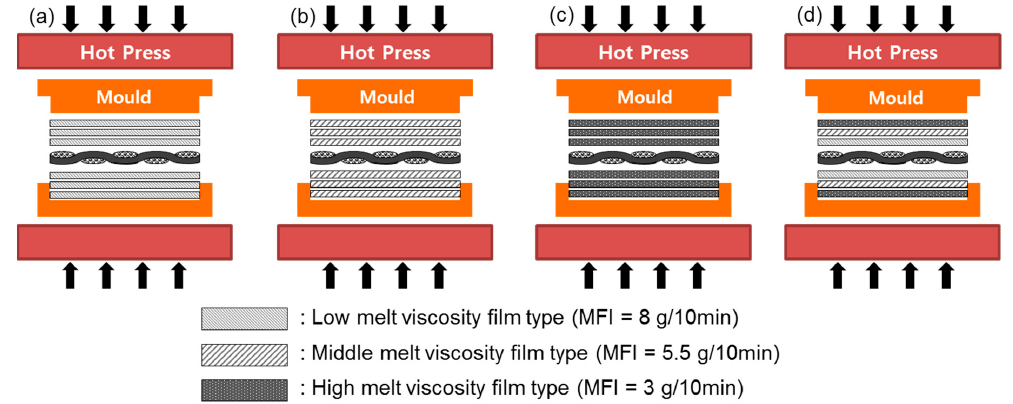
Figure 1. Schematic diagram of hot press processing: ( a ) low viscosity film type; ( b ) middle viscosity film type; ( c ) high viscosity film type and ( d ) combination (low-middle-high viscosity) film type.